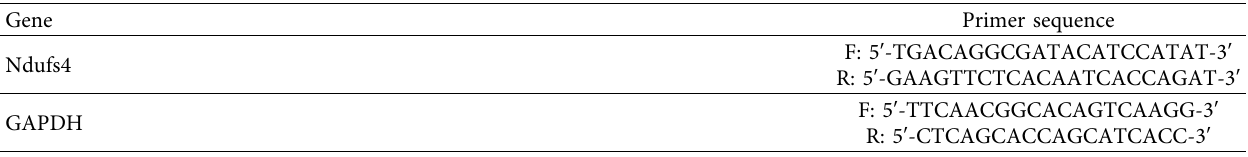
Table 1: Ndufs4 and GAPDH primer sequences for